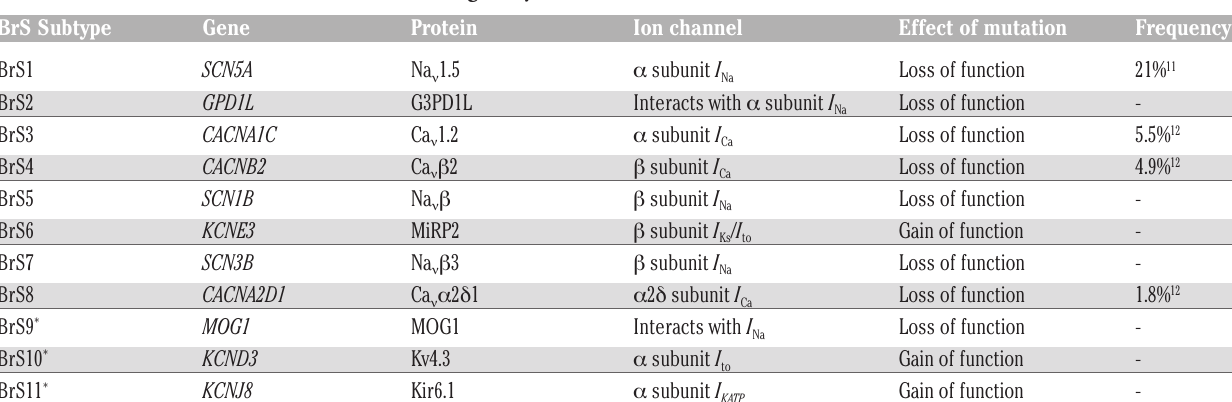
Table 2. Genetic mutations associated with the Brugada